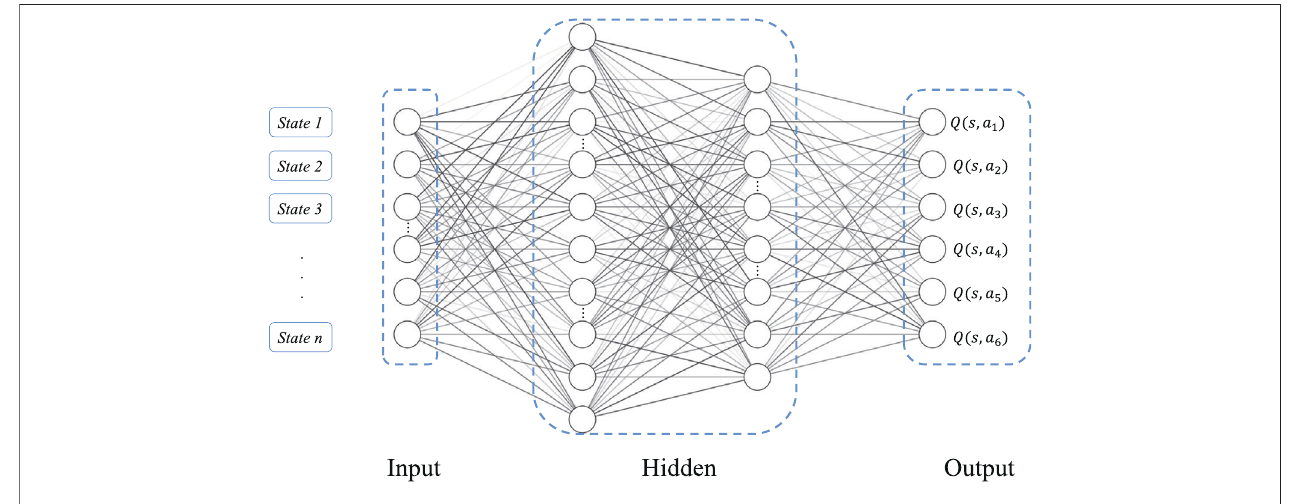
FIGURE 2 | Structure of the NMDRL multilayer neural network.